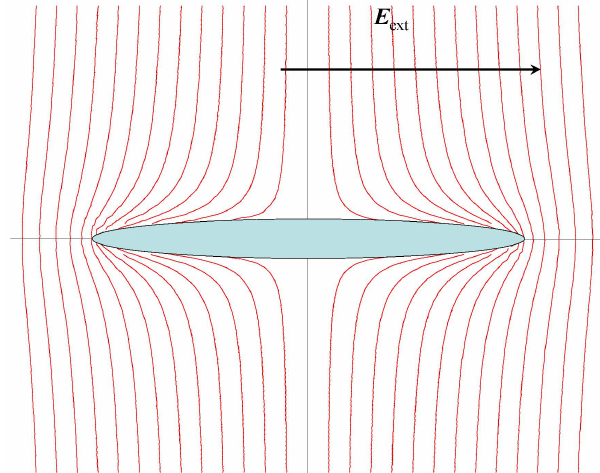
Fig. 3. Contours of equal potential (red curves) around an infinitely conducting ellipsoidal trail (shaded light blue). The external electric field direction (shown by the black arrow) is parallel to the major ellipsoid axis. The equipotential contours flow around the equipotential trail, resulting in build-up of strong electric fields near its boundary.